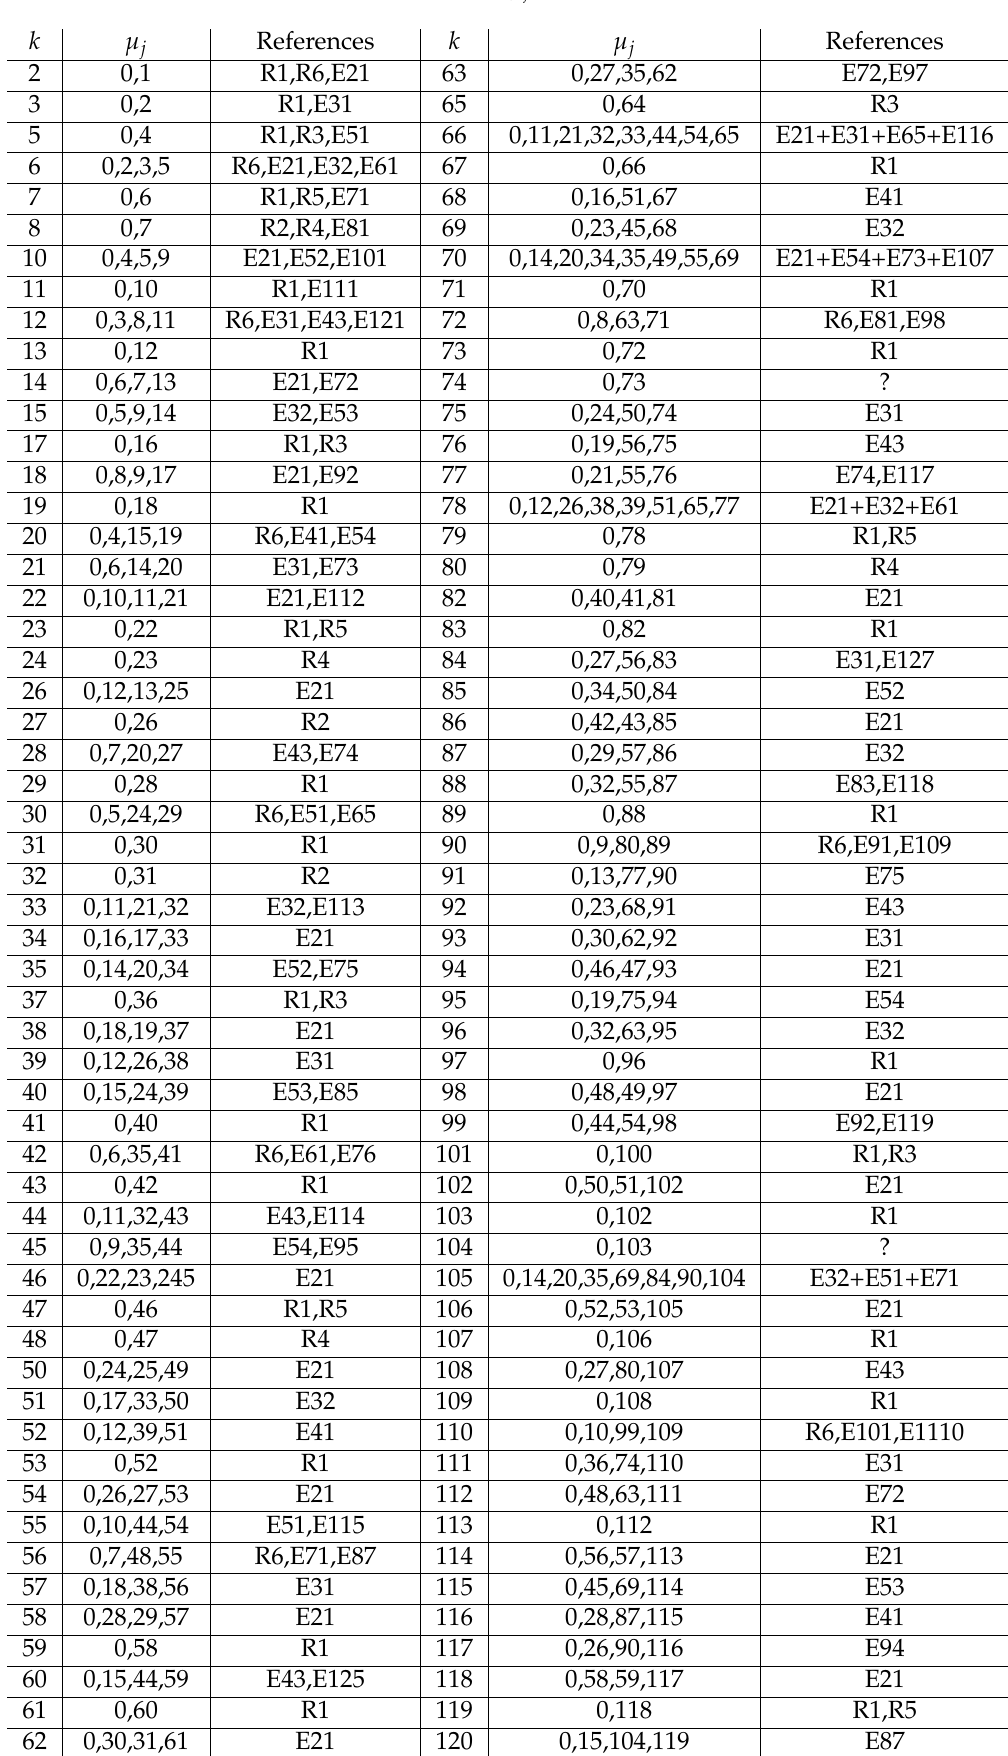
Table 5. Values of µ j for 2 ≤ k ≤